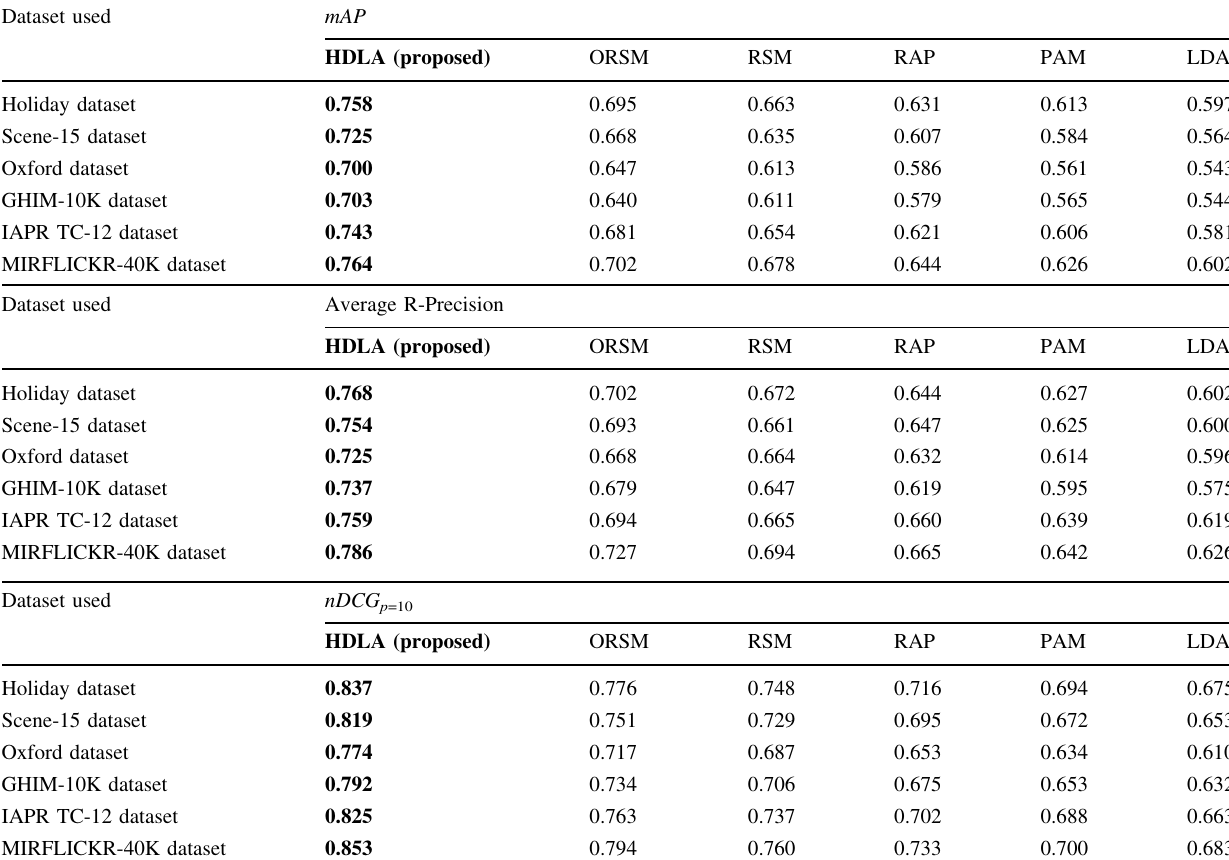
Table 4 Comparative evaluation of the proposed HDLA model based on mean average precision ( mAP ), average R-precision and normalized discounted cumulative gain ( nDCG ) calculated at rank position p =10 Dataset used